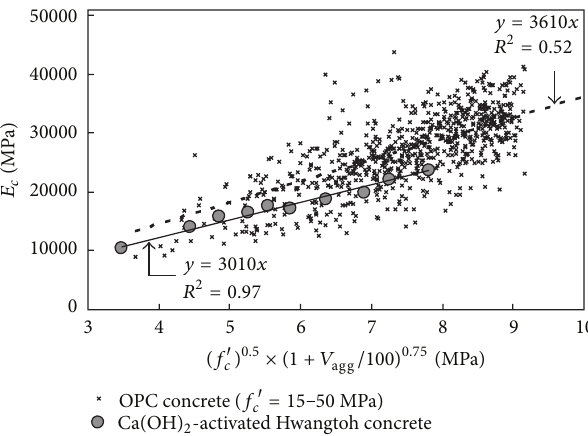
Figure 6: Regression analysis for modulus of elasticity ( 𝐸 𝑐